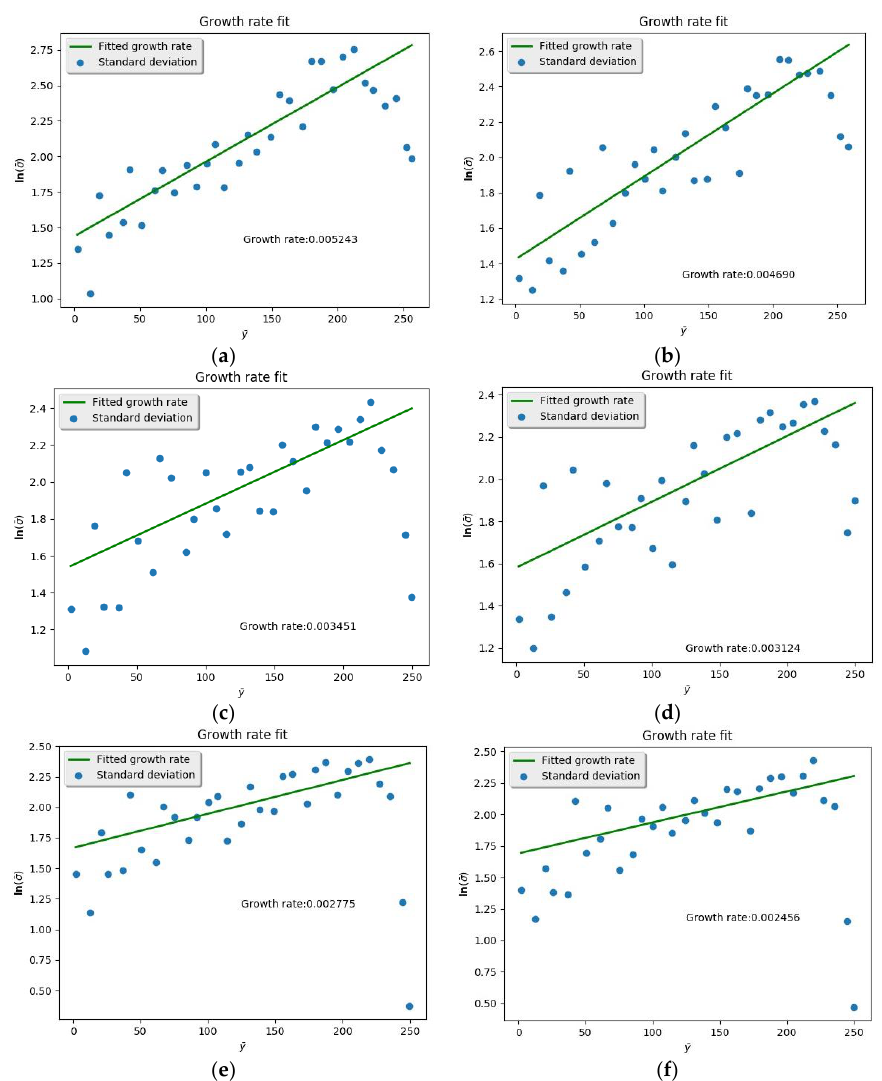
Figure 17. Spatial growth rate at different environmental temperatures (all environmental temperatures were over the critical point to the nitrogen and argon): ( a ) T = 300 K; ( b ) T = 400 K; ( c ) T = 500 K; ( d ) T = 600 K; ( e ) T = 700 K; ( f ) T = 800 K.